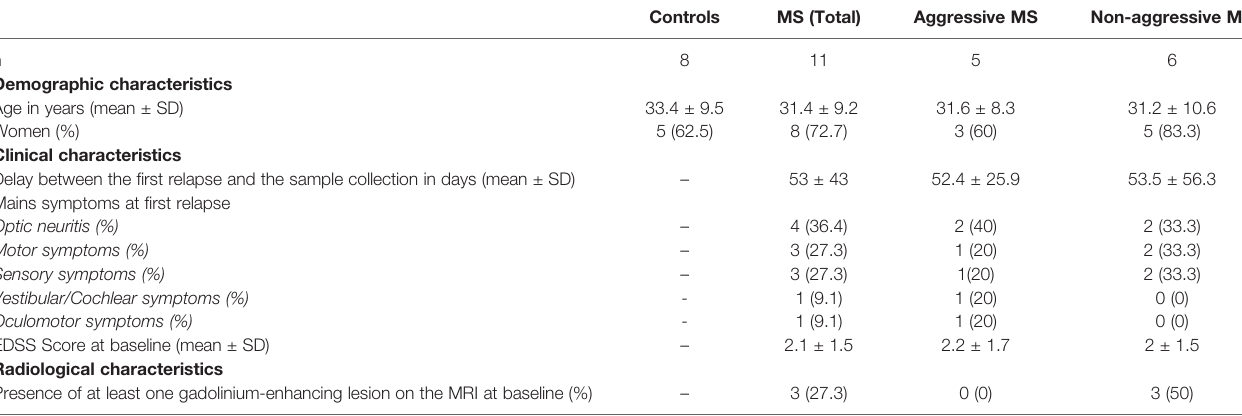
TABLE 1 | Characteristics of MS patients and healthy controls at